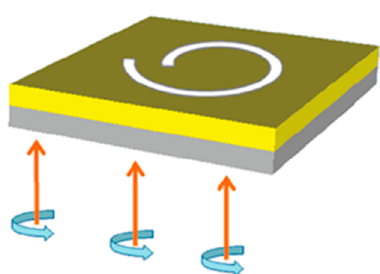
Figure 3. Schematic diagram of a single-turn left-handed Archimedes’ spiral plasmonic structure with CPL illumination. A single-turn left handed spiral (LHS) slit was etched through the gold film, which was deposited on the glass substrate. Reproduced with permission [31]. Copyright American Chemical Society, 2010.